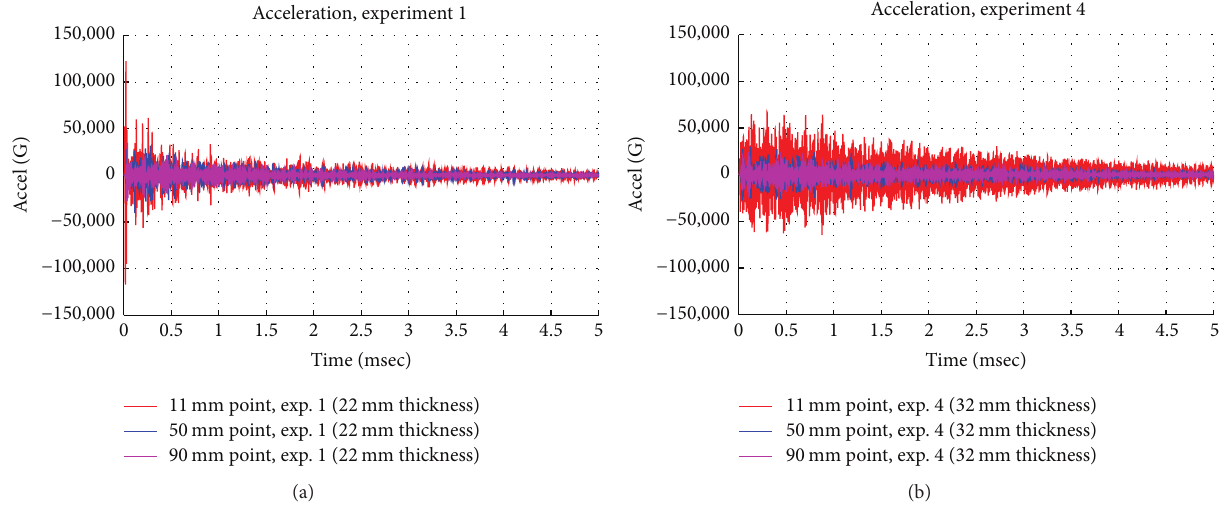
Figure 5: Measured pyroshock in terms of acceleration: (a) experiment 1 (the 22 mm thickness circular plate) and (b) experiment 4 (the 32 mm thickness circular